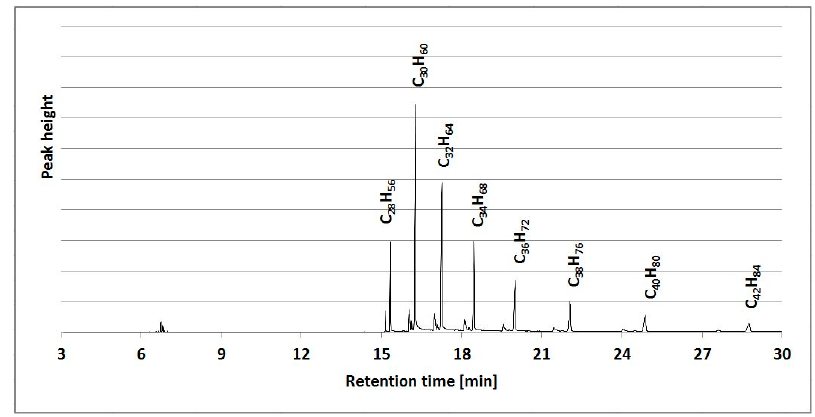
Figure 1. GC-MS chromatogram of starting material C30+ olefins (mass spectra Figures S1–S8).